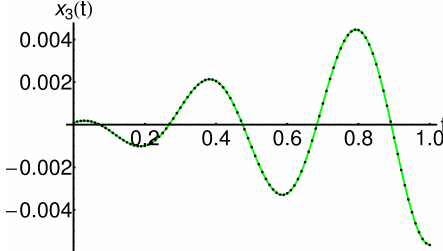
Fig. 3. Comparison between the approximate solutions ¯ x 3 given by Eq. (30) and the corresponding numerical